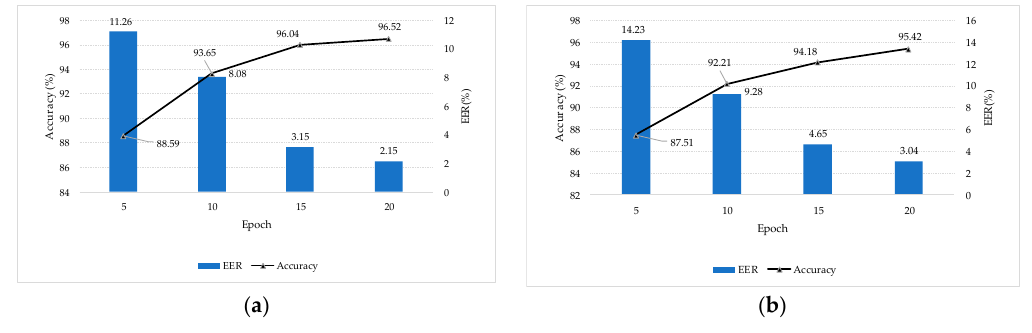
Figure 15. Separate tests of the TLCNN-RBM model using the speech collected in two environments. ( a ) Speech collected in quiet environment (laboratory) was used for retraining and recognition results, and ( b ) speech collected in noisy environment (supermarket) was used for retraining and recognition results.